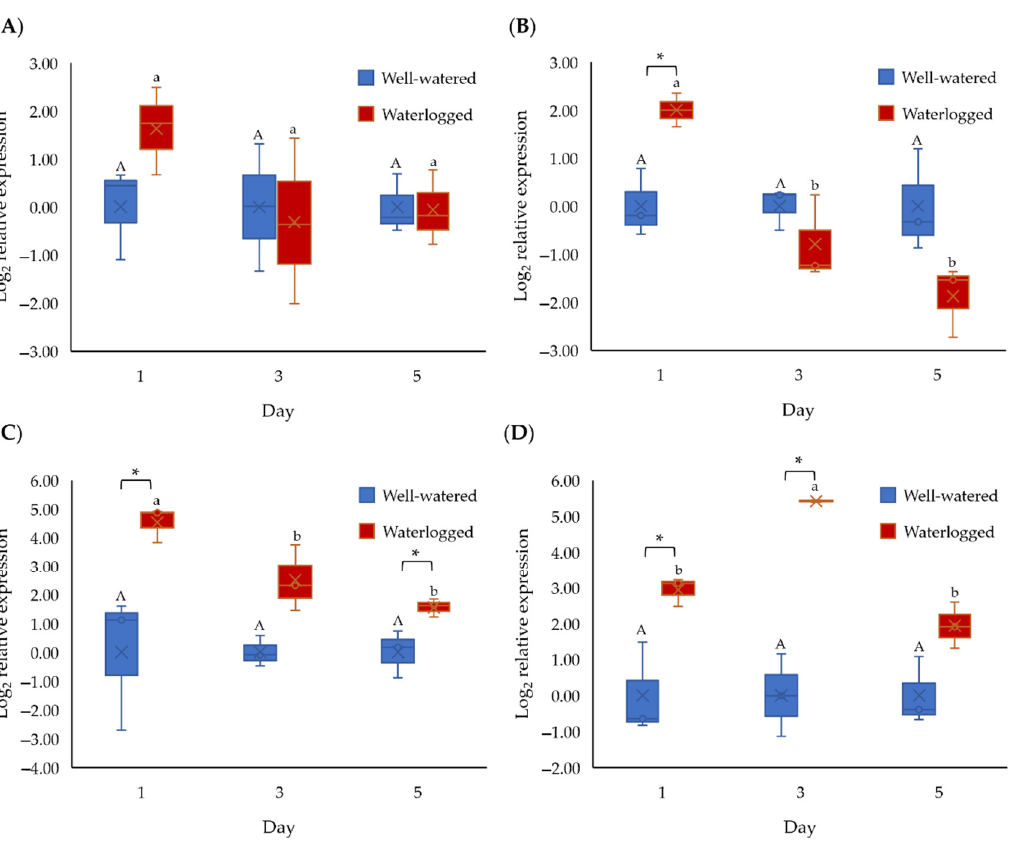
Figure 5. Gene expression of ( A ) MaERFVII-1 , ( B ) MaERFVII-2 , ( C ) MaERFVII-3 , and ( D ) ADH1 of banana for 1, 3, and 5 days of waterlogging. Error bars indicate standard error between biological replicates. Different capital letters indicate a significant difference between time points within well- watered samples. Different lowercase letters indicate a significant difference between time points within waterlogged samples. Asterisks (*) indicate a significant difference between well-watered and waterlogged samples at the same time point ( p < 0.05).